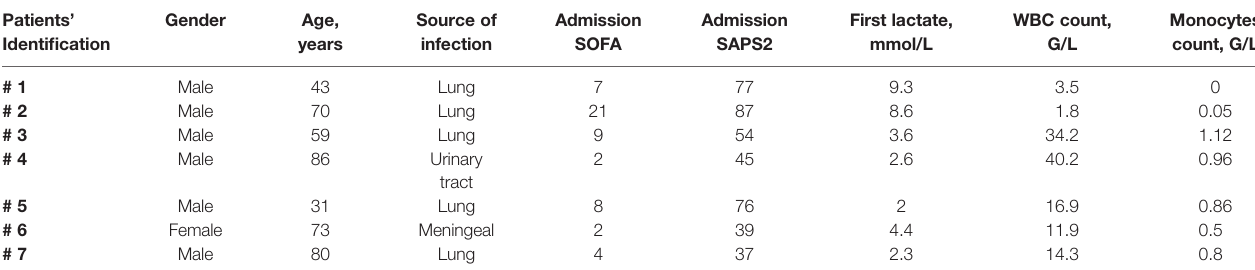
TABLE 1 | Main characteristics of patients with septic shock. Patients